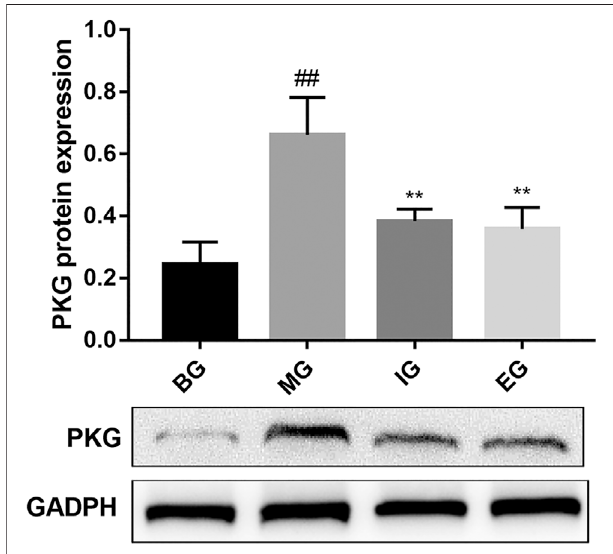
FIGURE 6 | The effect of emodin on the level of PKG protein in brain tissue induced by NTG. Values were represented as the mean ± SD ( n (cid:1) 6). ## p < 0.01 versus normal, and ** p < 0.01 versus the